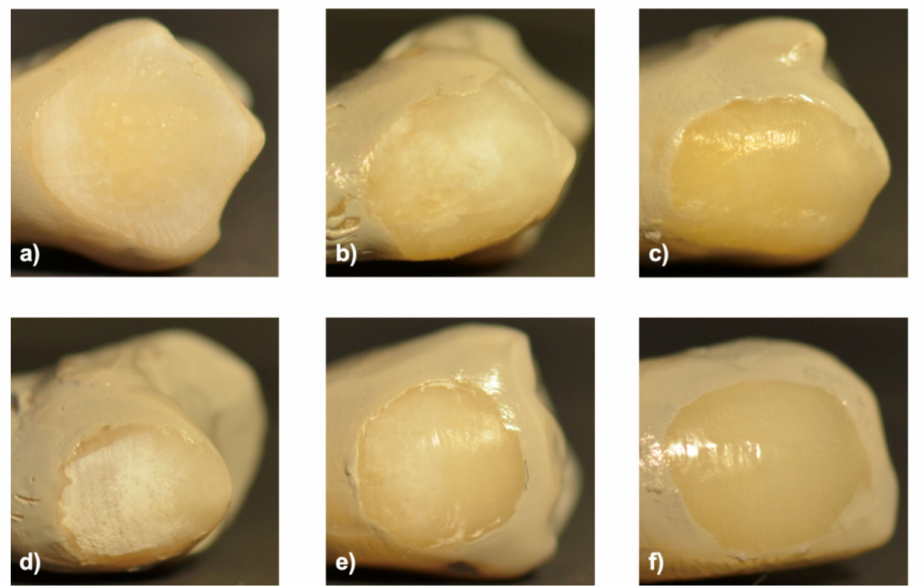
Figure 2. The enamel after being placed for 30 min in: ( a ) hydrochloric acid; ( b ) orthophosphoric acid; ( c ) lactic acid; ( d ) orthophosphoric acid solution; ( e ) formic acid; ( f ) CaCl 2 , NaH 2 PO 4 and acetic acid solution.